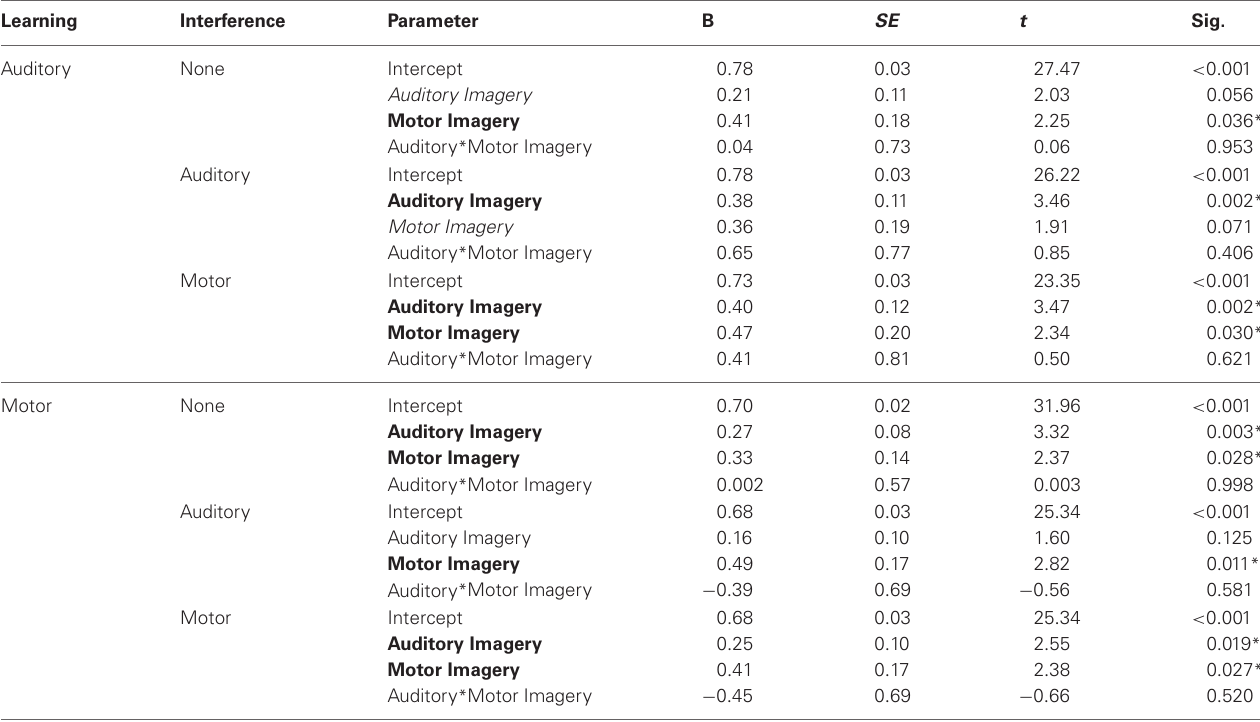
Table 1 | Experiment 1: Parameter estimates for auditory and motor imagery effects by